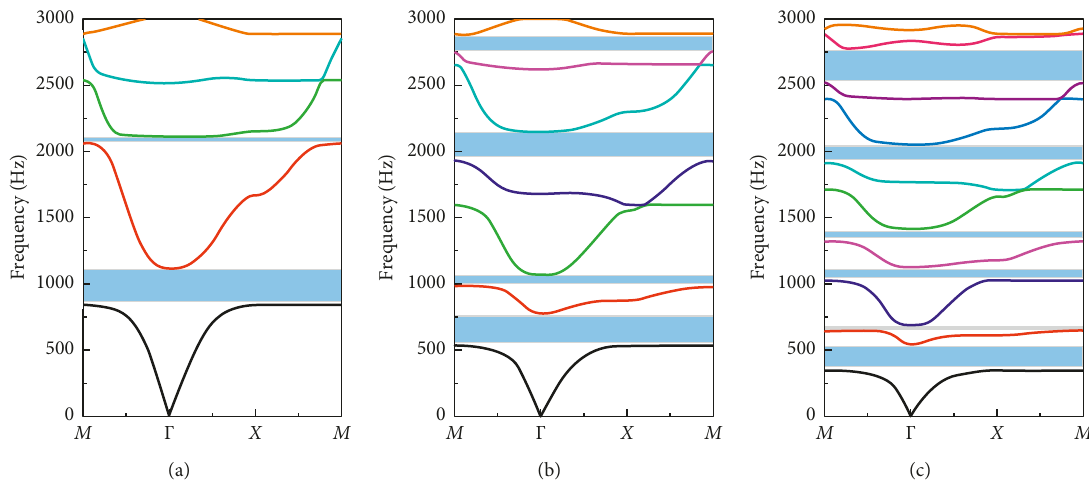
Figure 2: Band structures of fractal acoustic metamaterials. (a) Band structure of first-order fractal acoustic metamaterials in the frequency range [0 Hz, 2850Hz]. (b) Band structure of second-order fractal acoustic metamaterials in the frequency range [0 Hz, 2850Hz]. (c) Band structure of third-order fractal acoustic metamaterials in the frequency range [0 Hz, 2850Hz]. 0.00.20.40.60.81.0 R